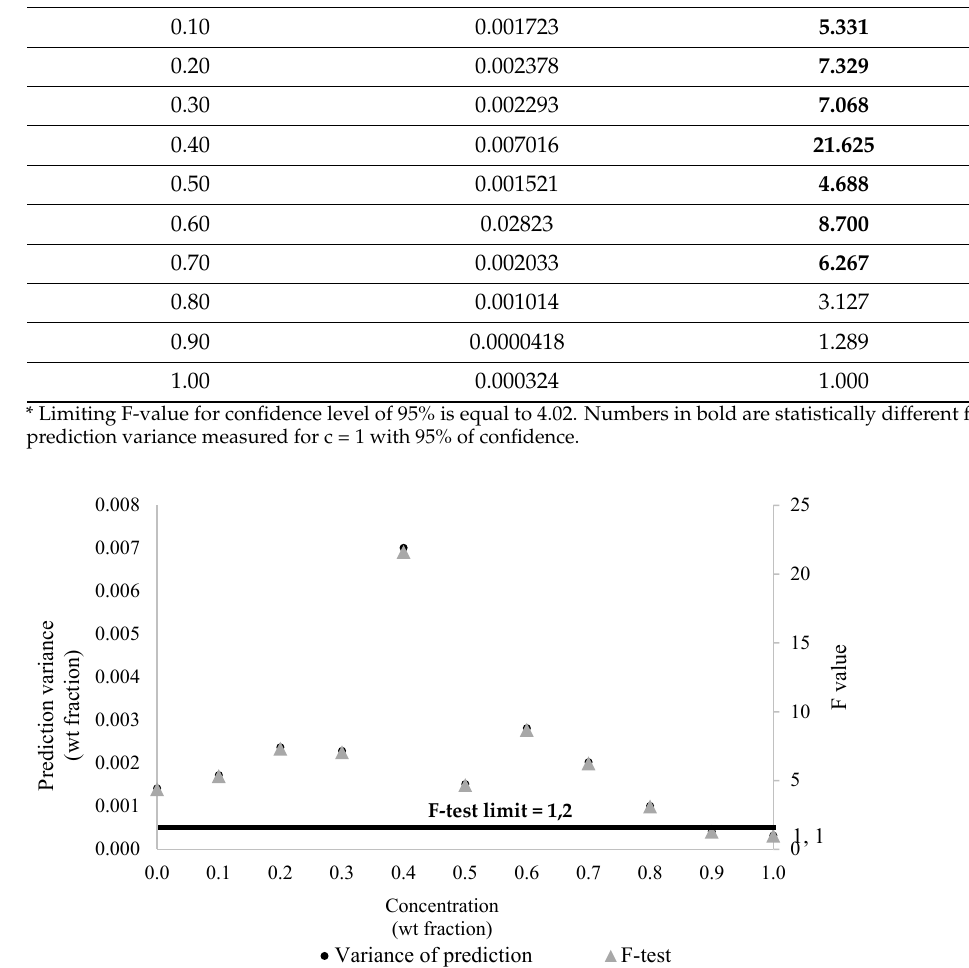
Table 2. Data for error prediction for different xylene concentrations at 90 °C and 450 rpm using H- PCR method. Concentration [wt Fraction]